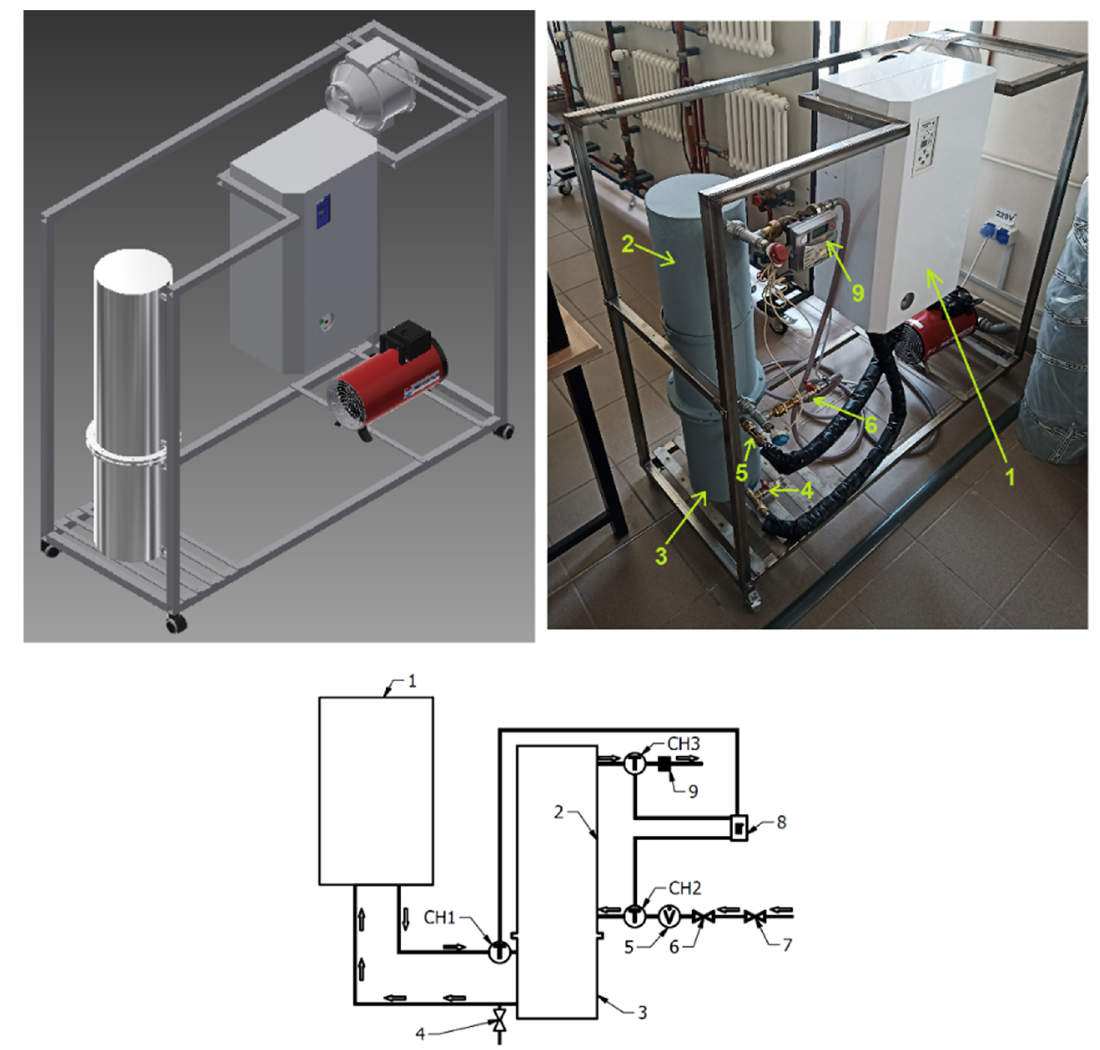
Figure 3. The experimental stand: 1—Electric heater, 2—Condenser, 3—Evaporator, 4—Faucet for filling/emptying the primary circuit, 5—Flowmeter, 6—Faucet for controlling the volume flow rate, 7—Water supply faucet, 8—LT BTM-420SD electronic thermometer, 9—Elterm CF 55 flow temperature meter.